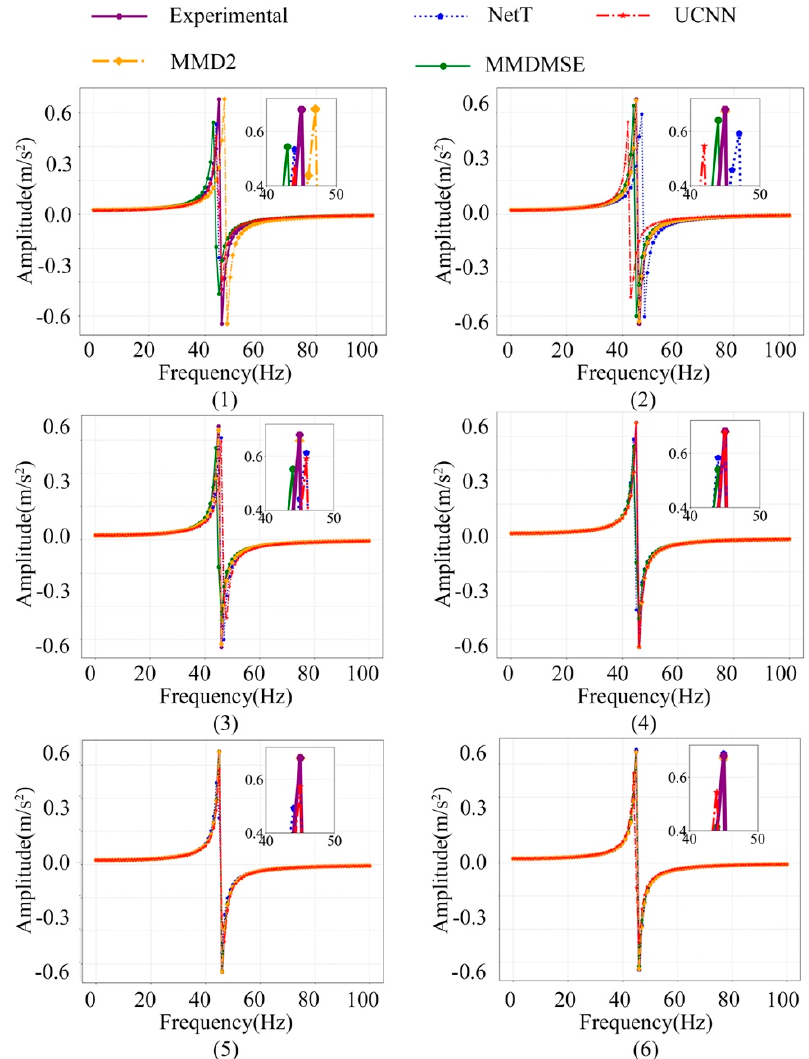
Figure 9. The FR signal of the No. 7 sampling location at the Z orientation sampling location with an increasing number of training samples ((1)–(6) represent for 100, 200, 500, 1000, 2000, 4000 samples).